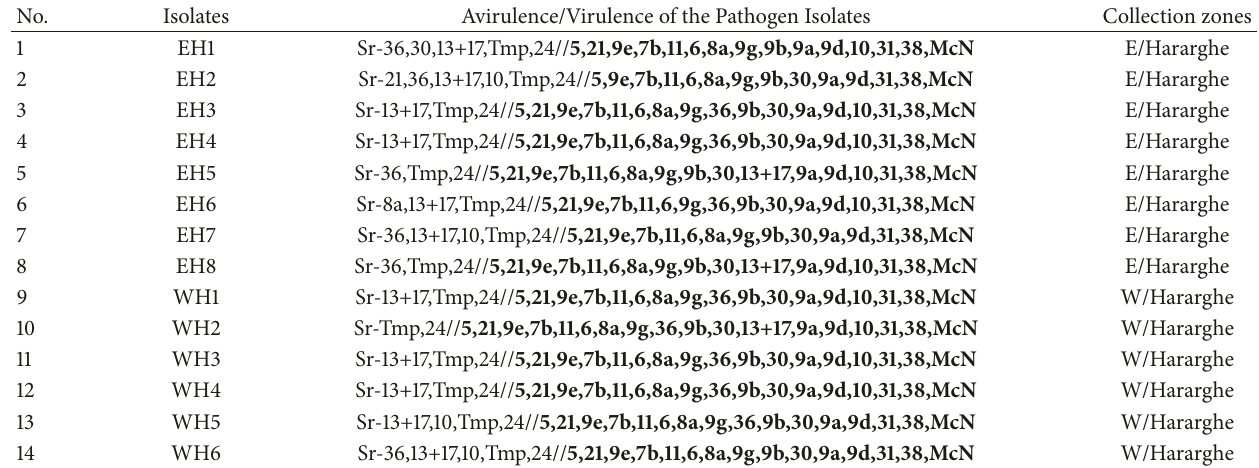
Table 5: Avirulence/virulence formula of 14 isolates of Puccinia graminis f. sp. tritici identified from both East and West Hararghe Zones. No.